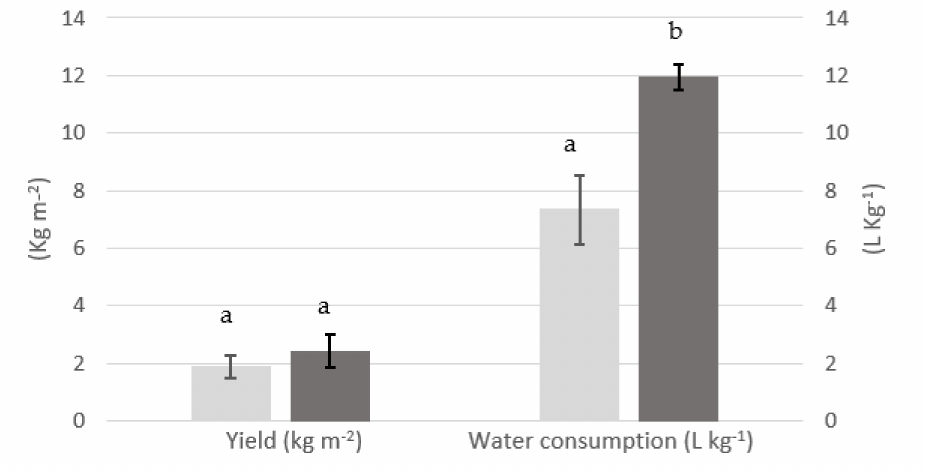
Figure 5. Yield of lettuce and water consumption by use of the organic and the conventional nutrient solution. Different letters indicate statistically significant